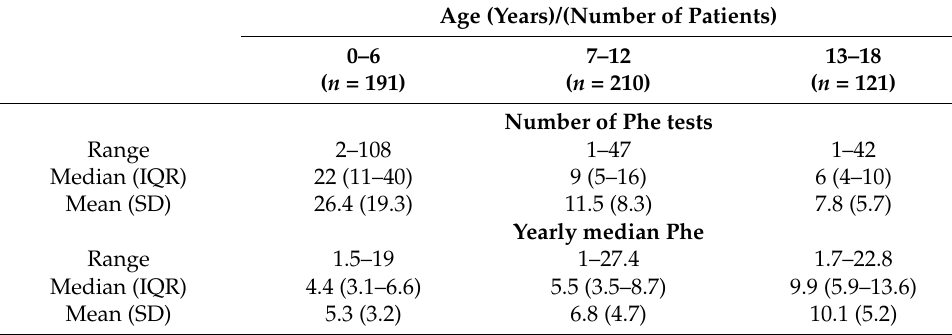
Table 2. Basic characteristics of blood testing and phenylalanine (Phe) concentrations in the year 2019 in the studied 522 patients with